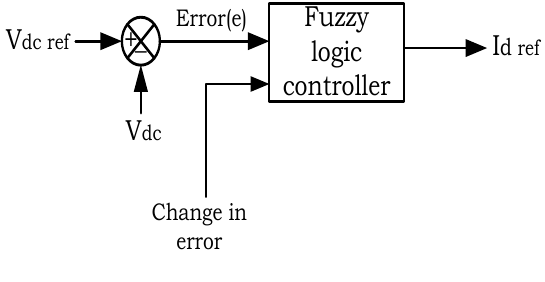
Figure 5. Fuzzy logic controller based DC link voltage controller